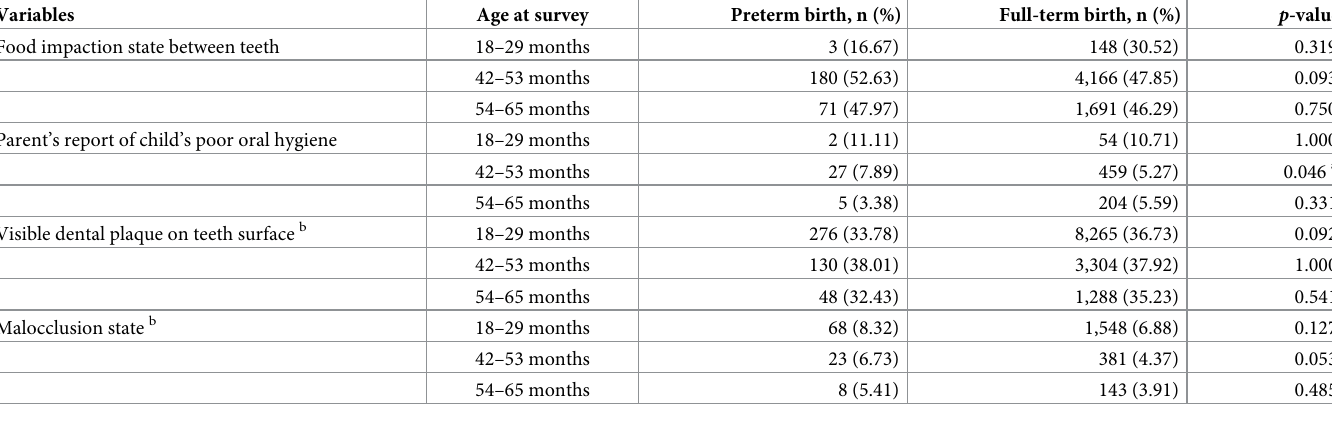
Table 3. Oral characteristics of preterm and full-term children in oral health screening.